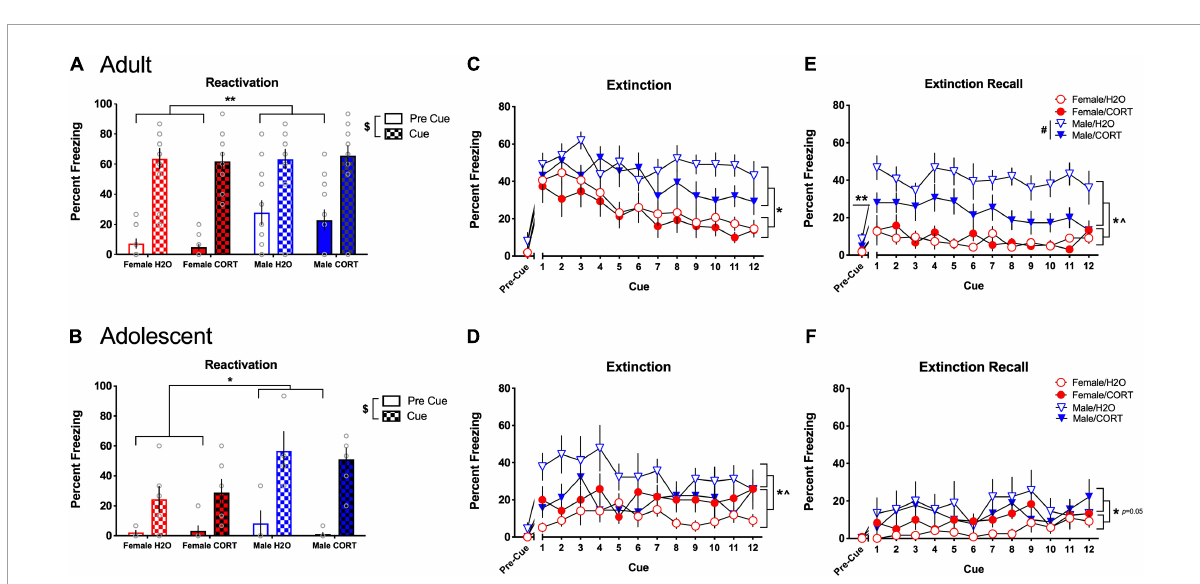
FIGURE6 CORT exposure alters fear-related behavior in a sex- and age-dependent manner. In adult-treated rats, all rats increased freezing during the cue compared to the pre-cue period, with males initially showing more freezing than females (A) . In adolescent-treated rats, all rats increased freezing during the cue compared to the pre-cue period, with males rats showing more freezing than females when the cue was present (B) . Adult-exposed males exhibited significantly higher freezing compared to females during extinction (C) and extinction recall (E) . Apparent deficits in extinction learning in adult H 2 O-treated males led to significantly higher overall freezing in male rats during the pre-cue period of extinction recall, and H 2 O-treated males showed significantly greater freezing during recall compared to their CORT-treated counterparts. Adolescent-exposed males also exhibited significantly higher freezing compared to females during extinction (D) , and a significant sex × treatment interaction indicated that freezing was greater in H 2 O-treated males relative to their CORT-treated counterparts, while female rats showed the opposite pattern. However, no effects of adolescent treatment were evident during recall (F) , and only effects of sex reached the level of significance. ** p < 0.05 (male vs. female during the pre-cue period); * p < 0.05 (male vs. female during the cue period); $ p < 0.001 (pre-cue vs. post-cue); # p < 0.01 (H 2 O vs. CORT), ˆ p < 0.05 sex × treatment interaction.